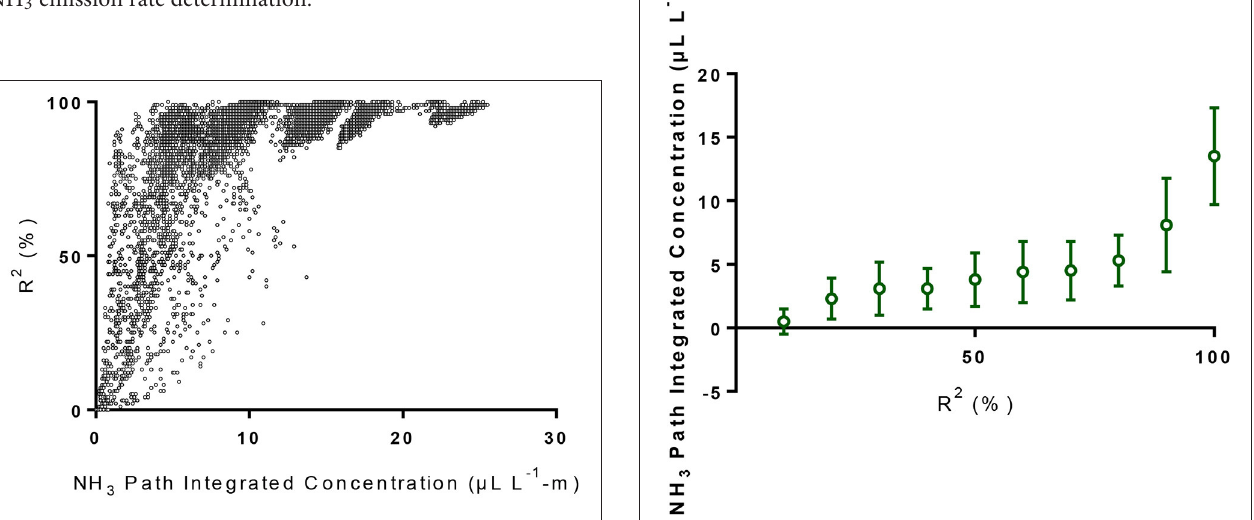
FIGURE 1 | Individual NH 3 path integrated concentrations (PICs) with associated R 2 . FIGURE 2 | Average NH 3 path integrated concentrations at desired R 2